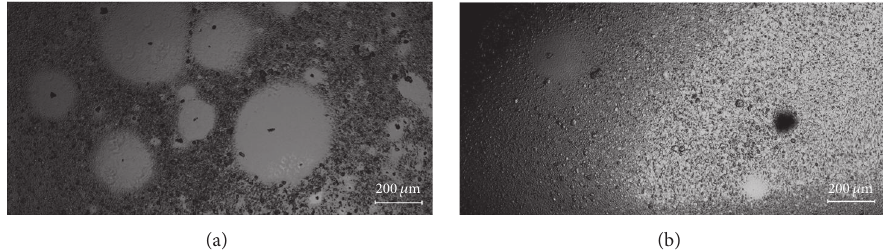
Figure 3: Clear zones of several hundred micrometers were seen around single particles five minutes after placing droplets on the glass slide. (a) Representative QELBY powder droplet, still wet; (b) representative silica powder droplet, still